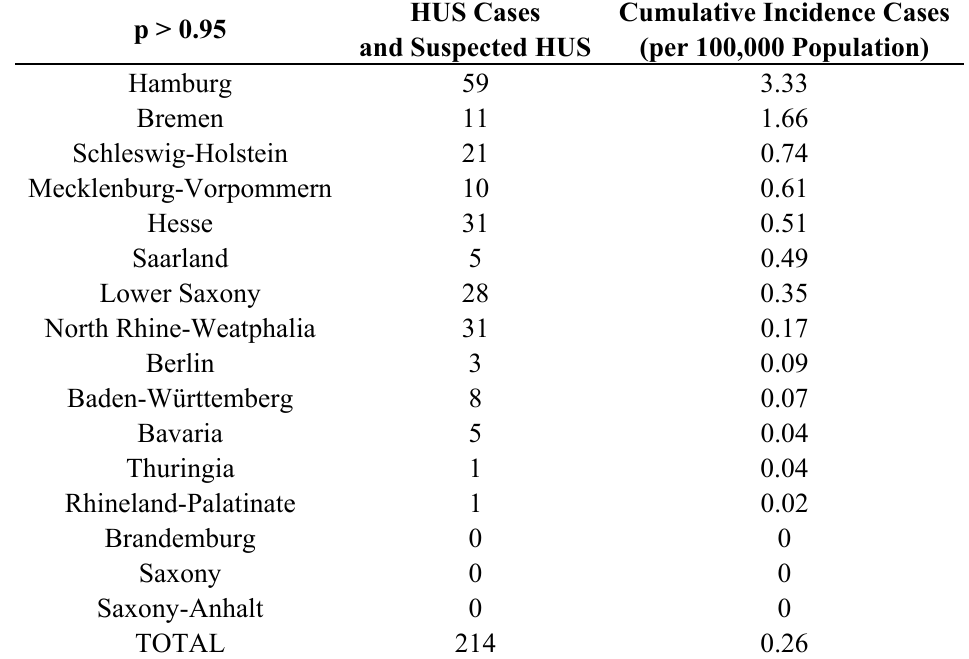
Table 7. Lists of the number of cases of HUS or suspected hemolytic uremic syndrome (HUS) [27,28]. p >